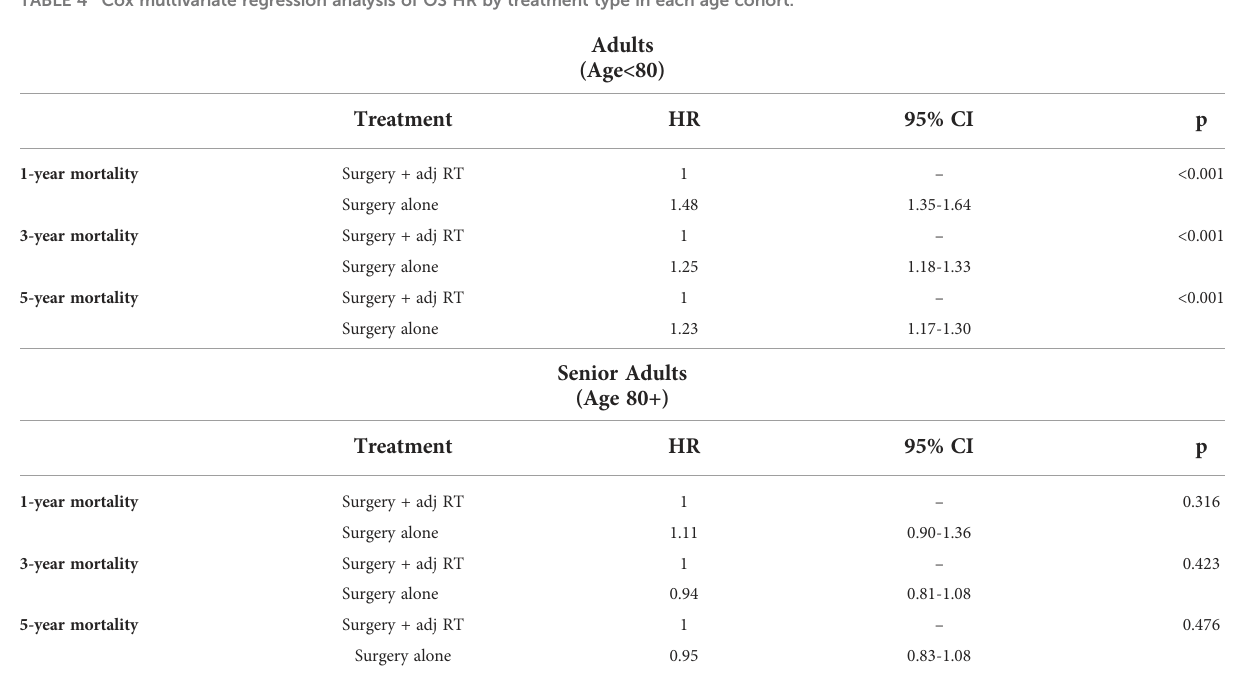
TABLE 4 Cox multivariate regression analysis of OS HR by treatment type in each age